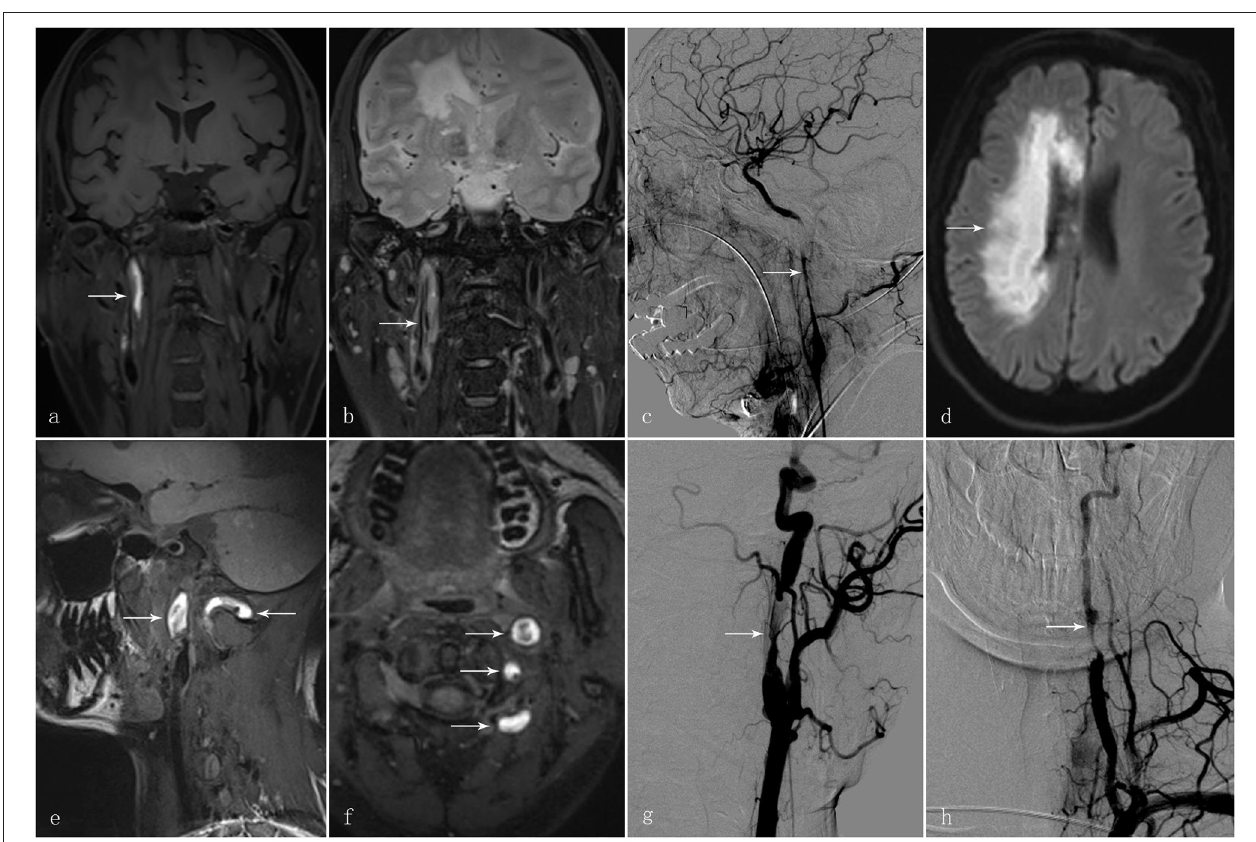
FIGURE 1 | A 58-year-old man presented with sudden-onset left hemiparesis and paraesthesia. (a) Coronal view of the high-resolution MRI T1 SPACE images showed an intramural hematoma at the C1 segment of the right internal carotid artery [ (a) ; arrow]. (b) T2 images demonstrated intimal flap and double lumen in the corresponding vessel wall [ (b) ; arrow]. (c) Digital subtraction angiography in the same patient showed long tapering stenosis at the C1 segment of the right internal carotid artery [ (c) ; arrow]; (d) Diffusion-weighted imaging demonstrated an acute infarct in the territory of the right internal carotid artery [ (d) ; arrow]. Another 30-year-old man presented with vertigo and vomiting after cervical manipulation. (e, f) The high-resolution MRI T1 SPACE images showed the intramural hematoma at the left internal carotid artery and vertebral artery [ (e, f) ; arrows]. (g) Digital subtraction angiography displayed irregular long tapering stenosis at the C1 segment of the left internal carotid artery and V2 segment of the left vertebral artery [(g, h) ;